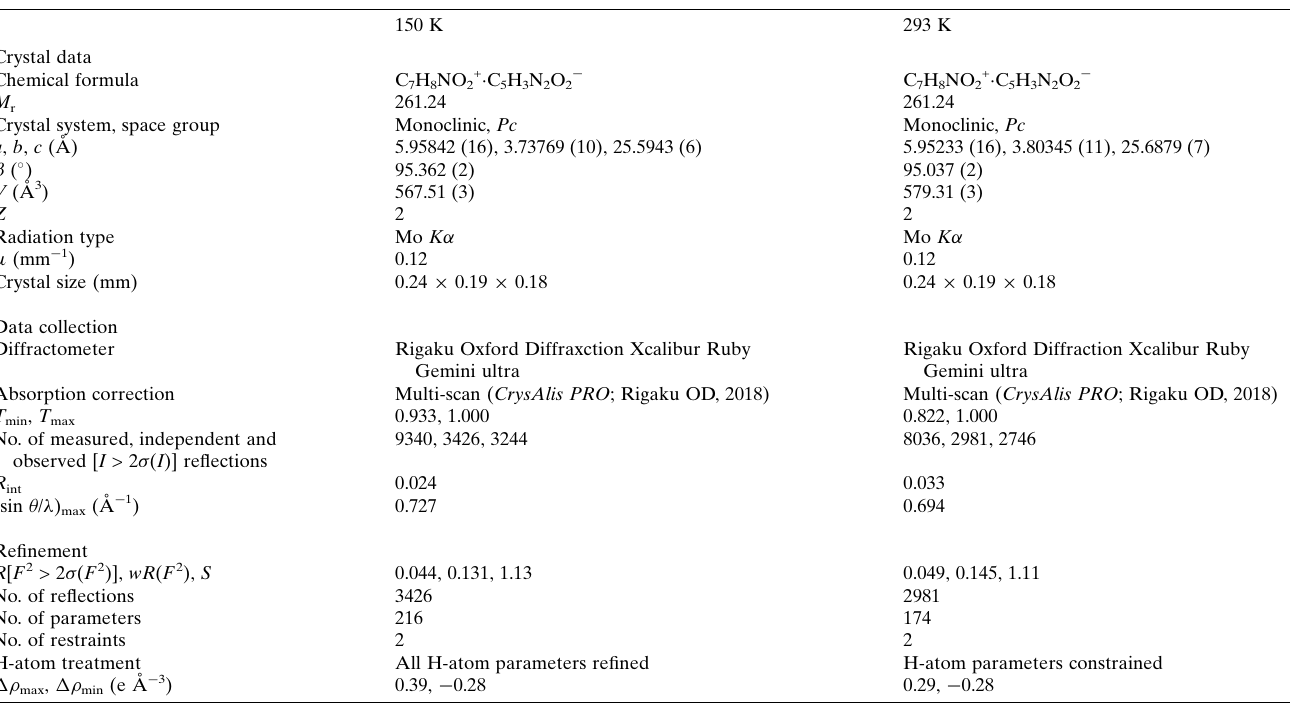
Table 3 Experimental details. Crystal data Chemical